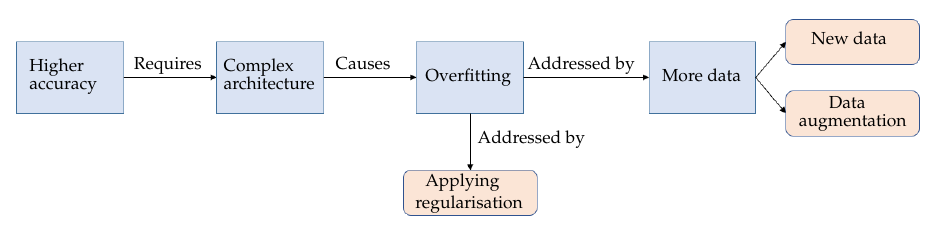
Figure 2. Diagram illustrating the overfitting problem and its well-known